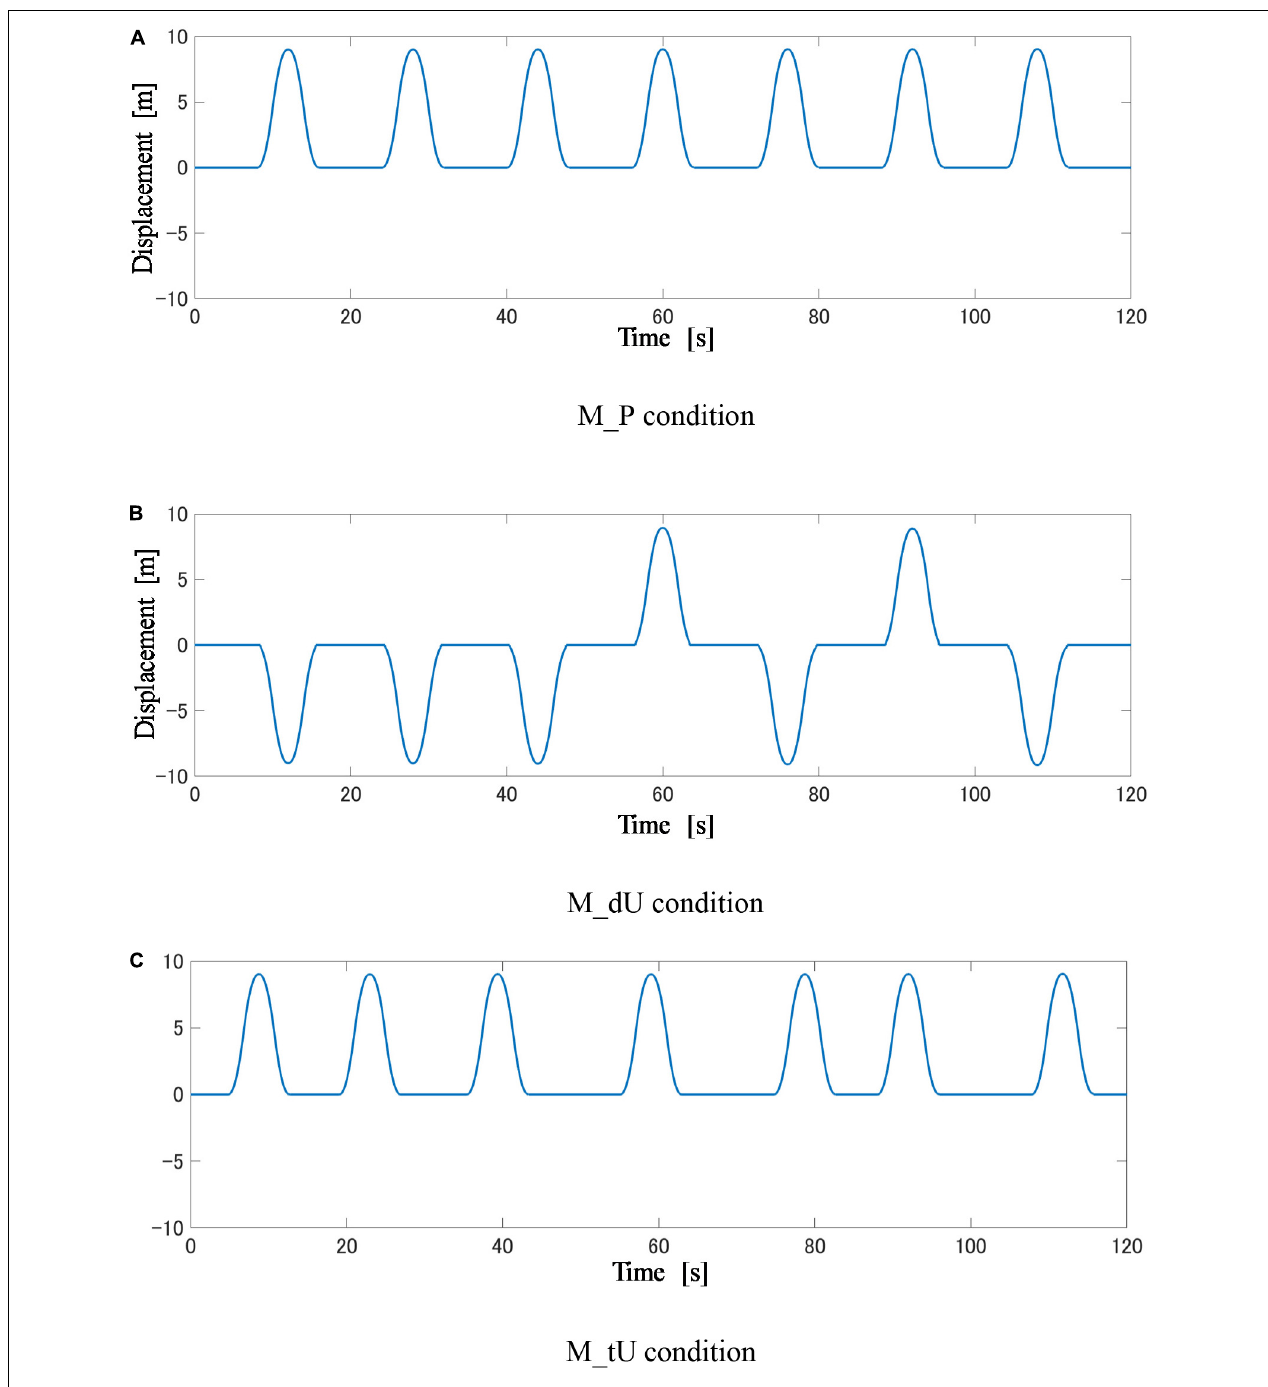
FIGURE 4 | (A–C) Motion profiles for three types of motion in the first 120 s.